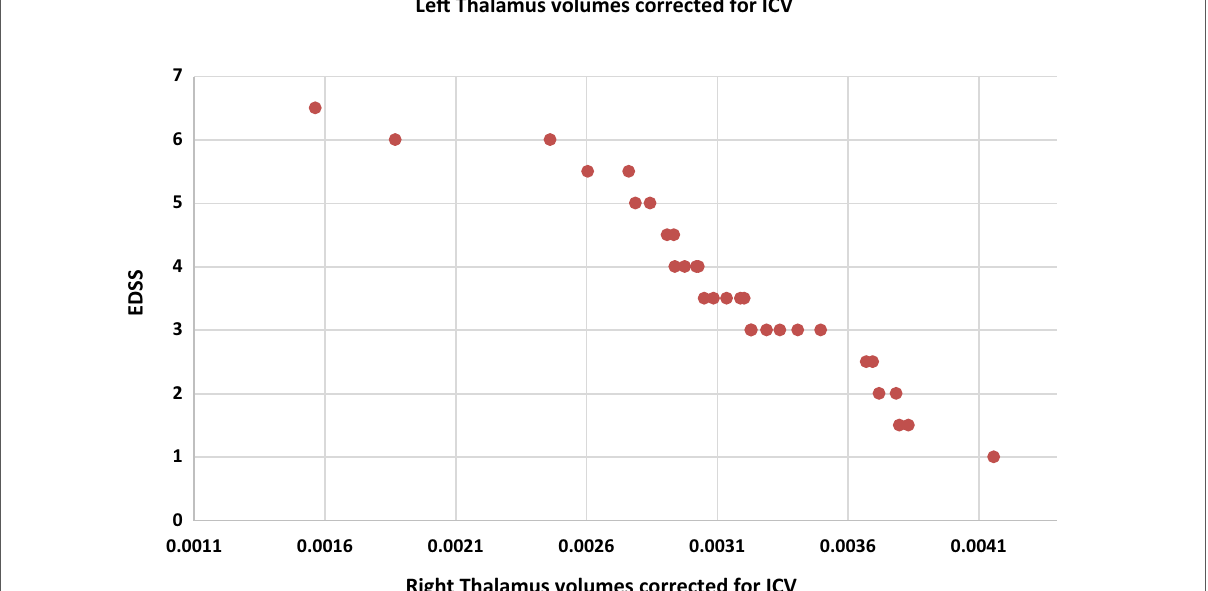
Fig. 1 Correlation between left and right thalamus volumes and EDSS